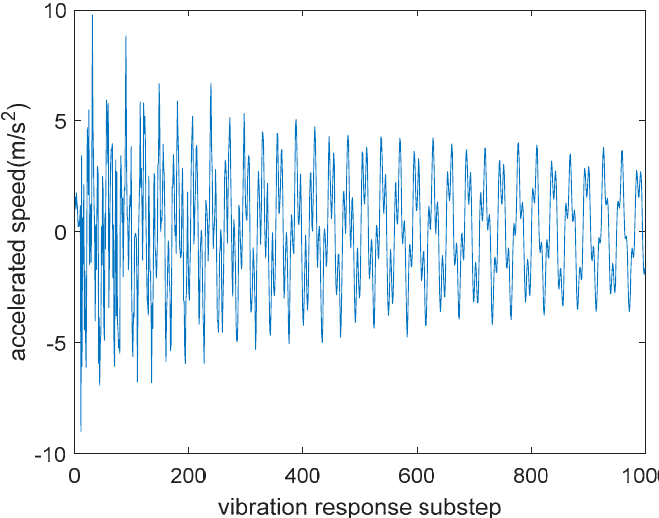
Figure 3. Shock response of 28th downside grid node with load acted on 28th upside grid node.